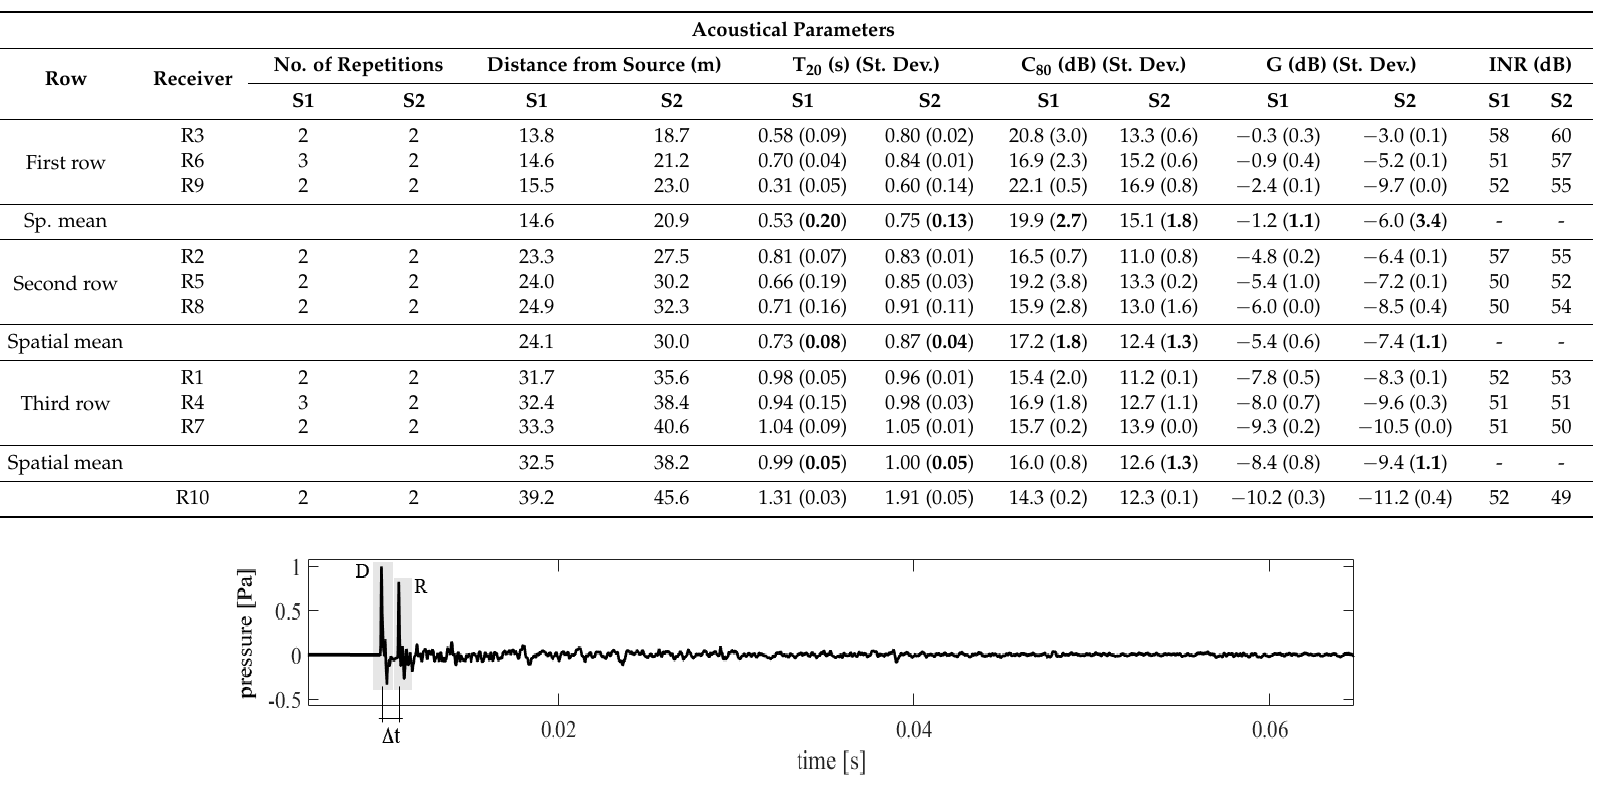
Table 1. Mean values and standard deviations of the measurements for the T 20 , C 80 and G acoustical parameters for the firecrackers, in positions S1 and S2. The data refer to the averages of the 500 Hz and 1 kHz octave bands and to the repetitions for the same receiver position. The rows spatial means are also reported. The standard deviations of the spatial means outside the JND range (for a definition see Section 4) are shown in bold. INR is also reported to help assess the quality of the measurements.